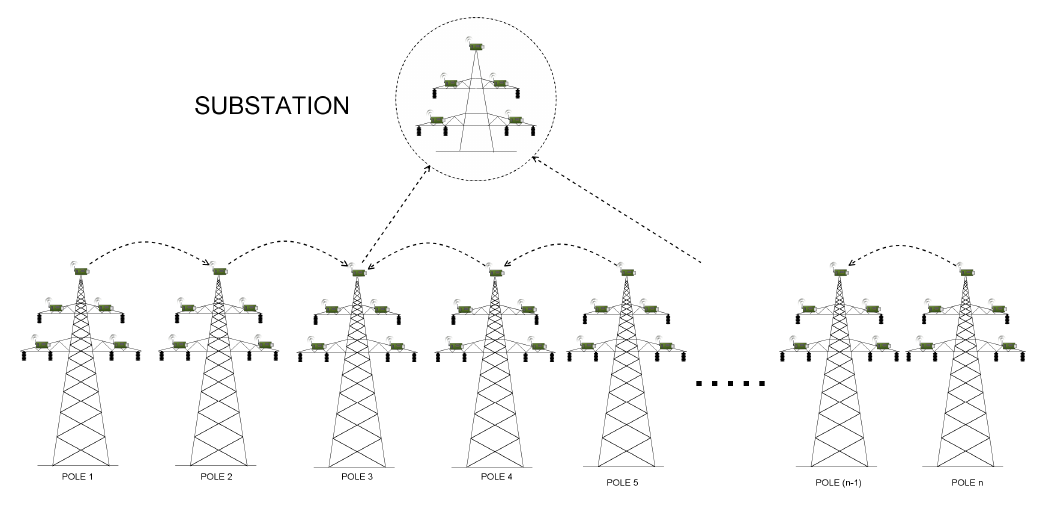
Figure 7. WSN architecture deployed on the example transmission grid, where η =